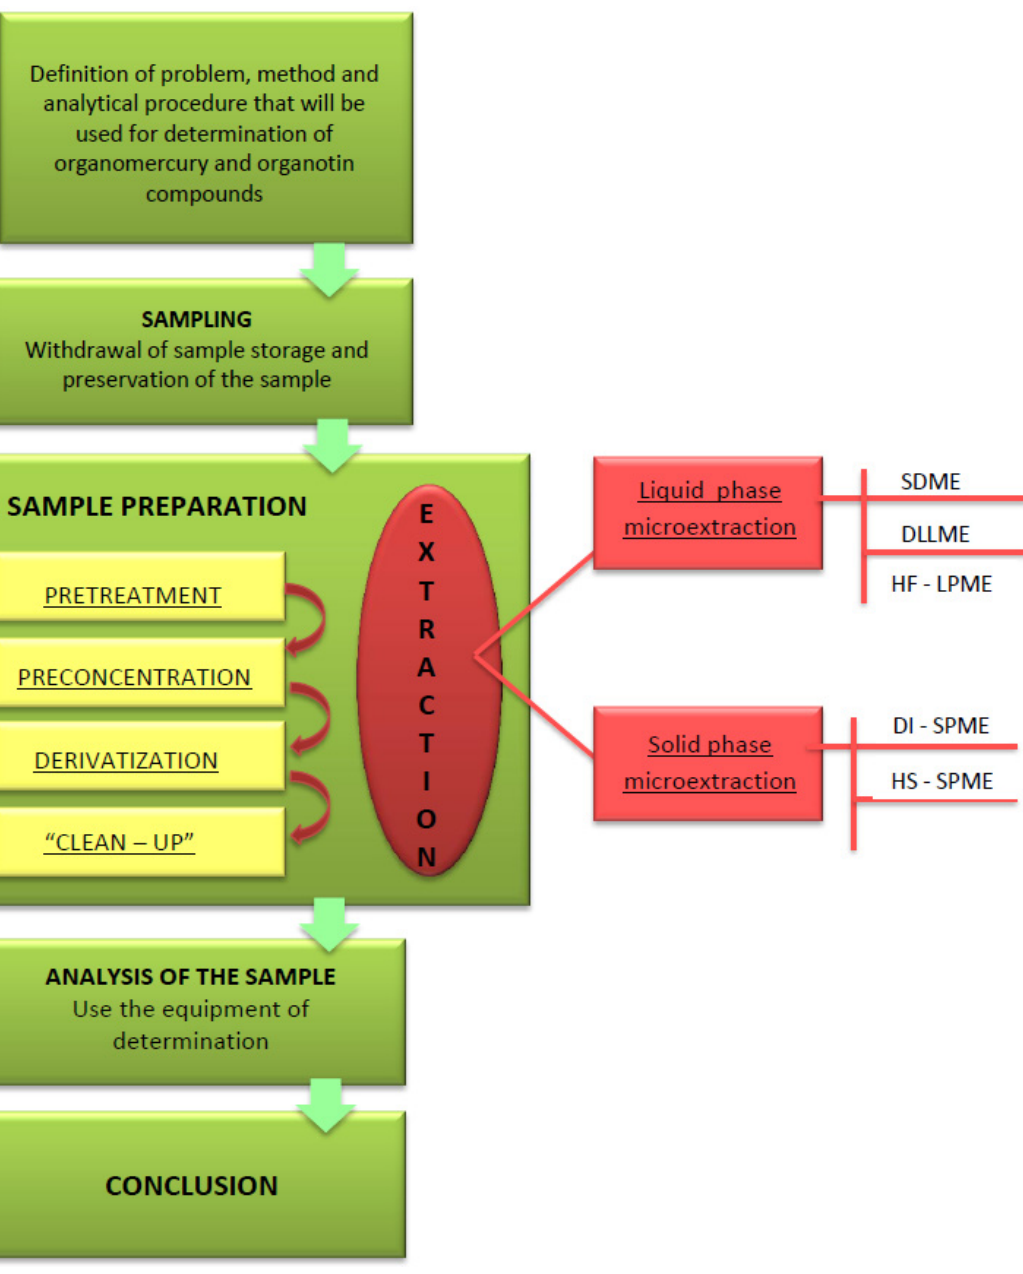
Figure 1. Diagram depicting the course of various procedures for determining organomercury and organotin compounds using microextraction techniques at the stage of preparing samples for analysis. Based on Oliveira, R. et al .